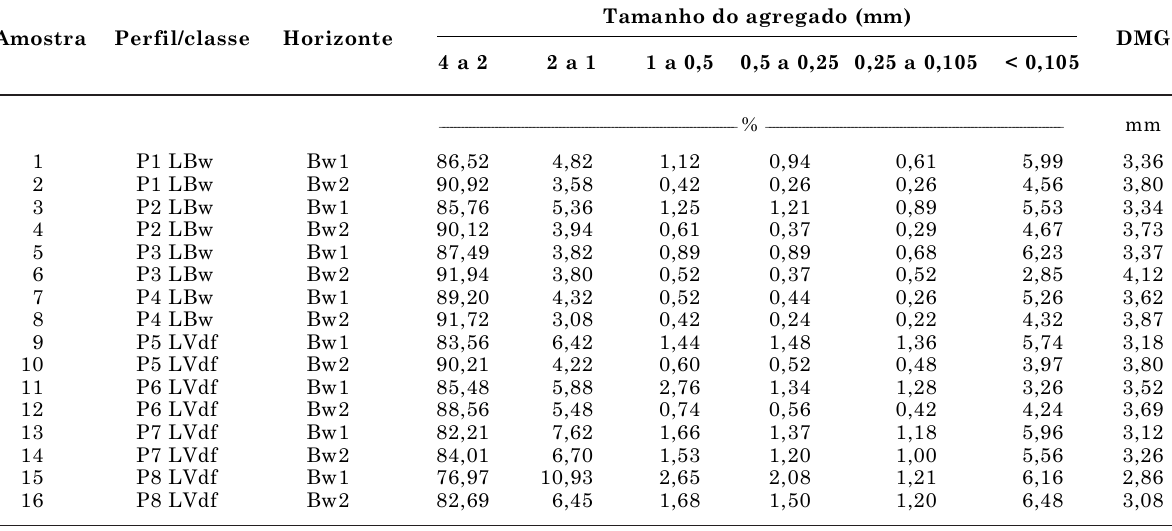
Quadro 3. Percentagem dos agregados retidos nas diferentes classes de peneiras no ensaio de